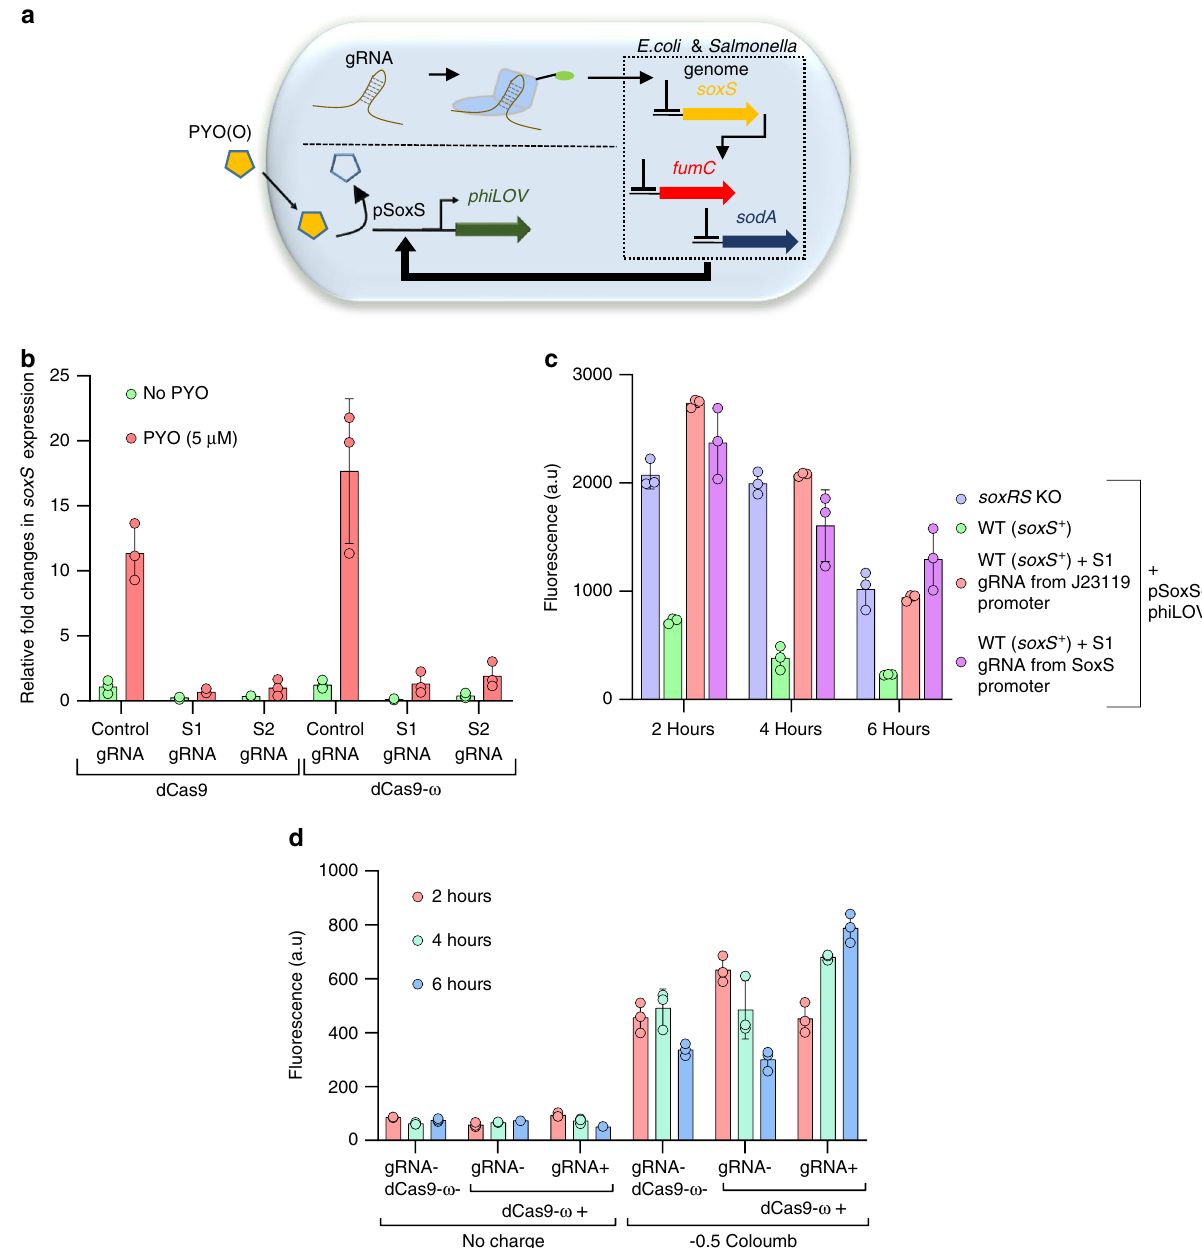
Fig. 4 eCRISPR multiplexing to attenuate noise and demonstrate portability. a Scheme of the CRISPR-mediated repression of soxS in the genome leading to an enhancement in the SoxS promoter activity. Two PAM sites in the E. coli soxS coding region are targeted with S1 and S2 gRNA ’ s respectively. As controls, a non-speci fi c control gRNA is used as well. All gRNA expressing plasmids were individually transformed into NB101 cells and both dCas9 and dCas9- ω are tested for gRNA mediated repression. b indicates relative fold changes in soxS expression after 3 h of induction with 5 µ M PYO. c phiLOV fl uorescence data indicating the increase in SoxS promoter activity when coupled with CRISPR-mediated soxS repression in the E. coli genome. Blue: DJ901 + pSoxS-phiLOV; Green: NB101 + pSoxS-phiLOV; Red: NB101 + pSoxS-phiLOV:pS1gRNA + pdCas9- ω ; Violet: NB101 + pSoxS-phiLOV + pSCSoxS- S1gRNA + pdCas9- ω . Under anaerobic conditions, OD 600 0.6 cells are induced for 6 h with 5 mM Fcn(O) and 5 µ M PYO and phiLOV fl uorescence is measured via fl ow cytometry. d Data indicating the CRISPR-mediated repression of soxS in the Salmonella genome leading to an enhancement in the E. coli SoxS promoter activity. S3 gRNA speci fi c to the soxS coding region in S. enterica is engineered into pSoxS-phiLOV to create pSoxS-phiLOV:pS3gRNA. This plasmid is transformed along with pdCas9- ω into Salmonella . As controls, pSoxS-phiLOV without the gRNA and dCas9- ω is used as well. Cells are grown to OD 600 0.6 in LB media, resuspended in minimal-M9 media and moved to an anaerobic chamber. For electrical induction, 5 mM Fcn(R) and 10 µ M PYO is added to cells and an electric charge of − 0.5 C is applied and phiLOV fl uorescence is measured via fl ow cytometry for upto 6 h. In all fi gures, independent experimental replicates ( n = 3) are represented by circles, height of the bars indicate mean and error bars indicate standard deviation. Source data for all fi gures is provided